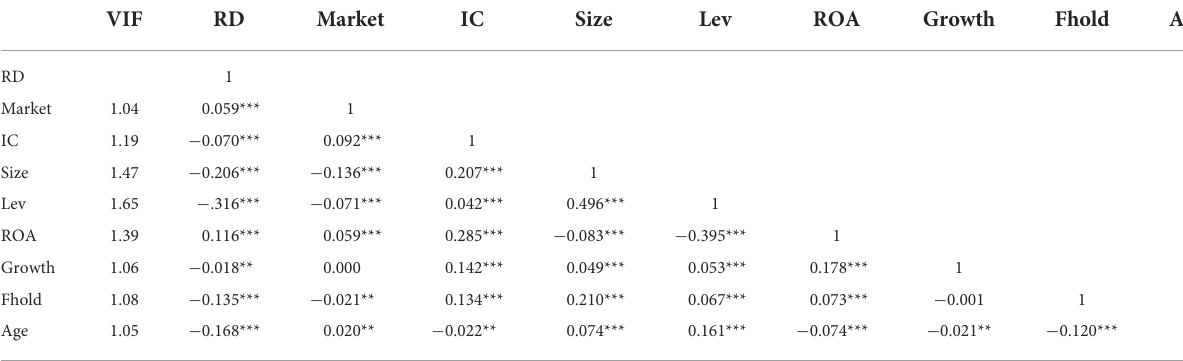
TABLE 3 Pearson-based correlation analysis results among main variables.